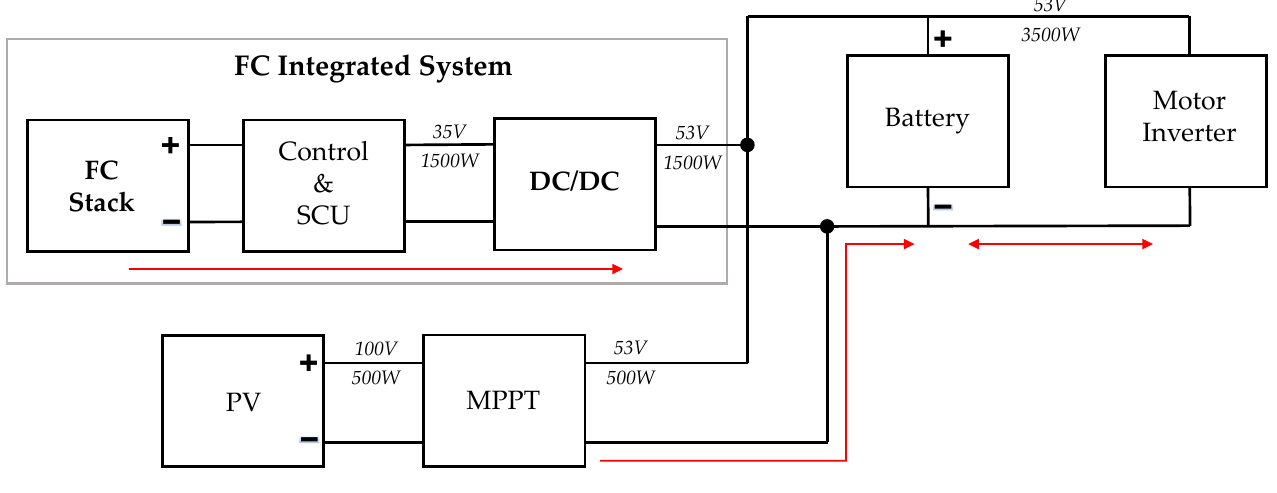
Figure 4. Traction chain scheme of the Futura catamaran and related energy flow diagram.